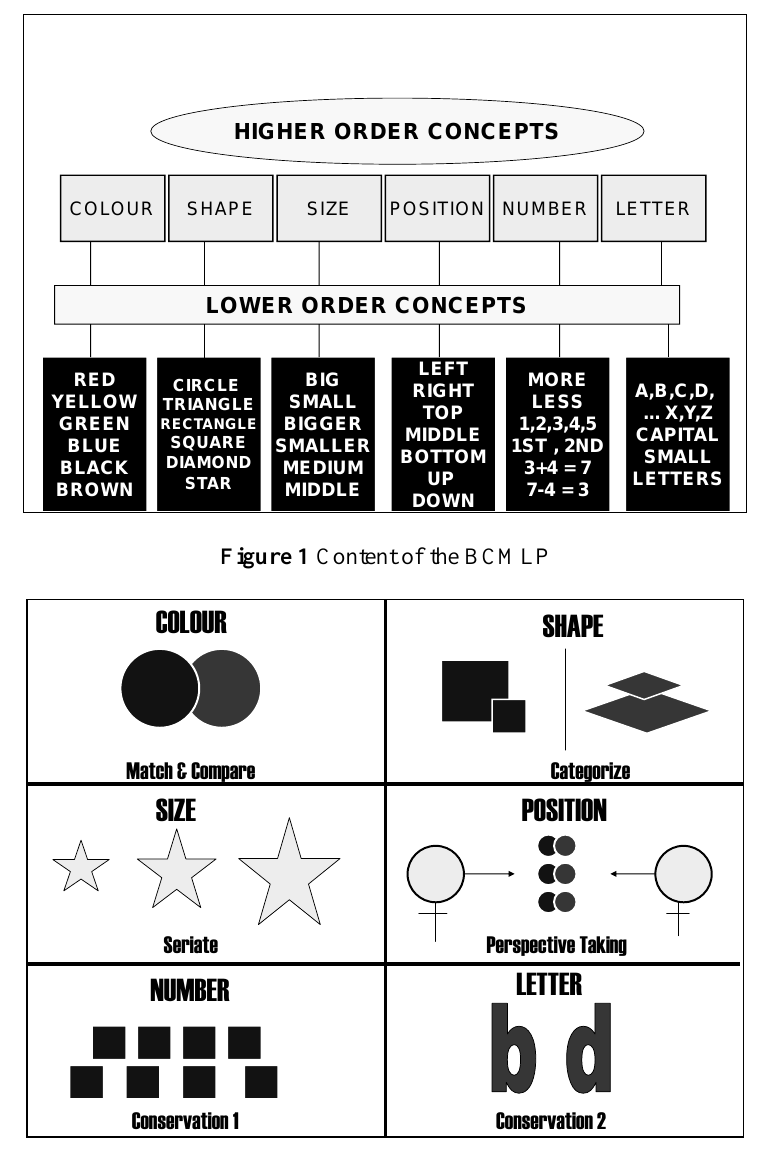
Figure 2 Cognitive Functions defined by the